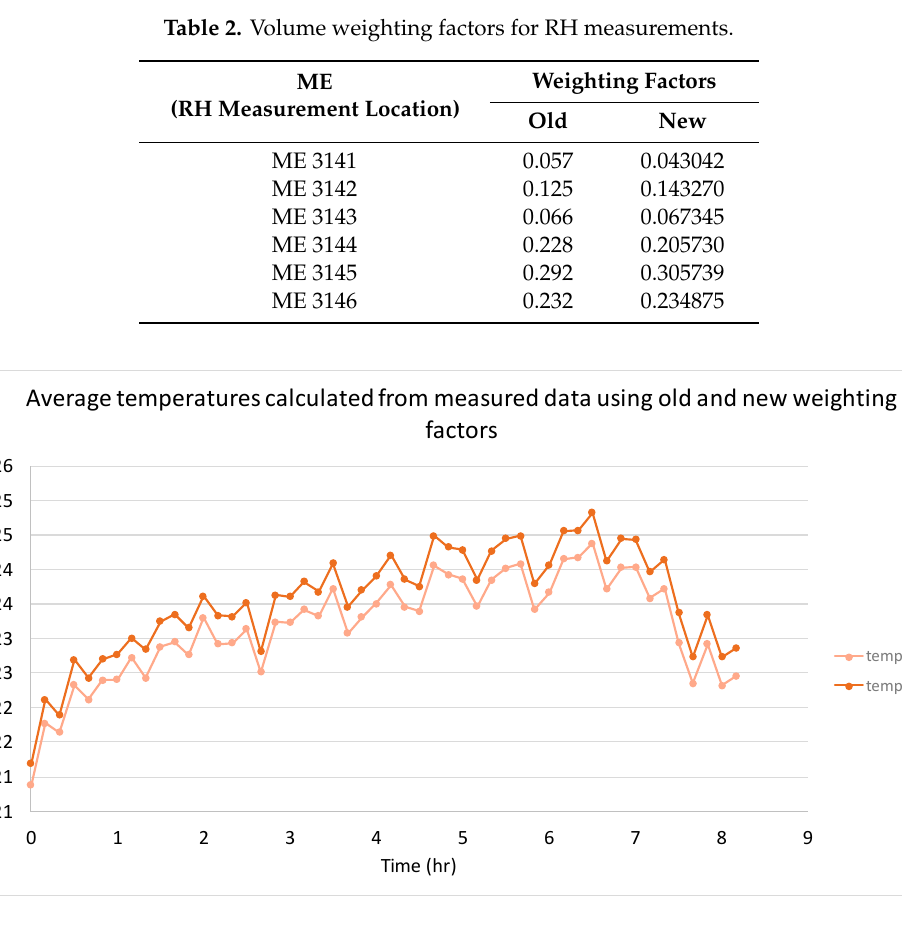
Figure 10. Average containment temperature change due to change in weighting factors. Table 1. Volume weighting factors for temperature measurements.